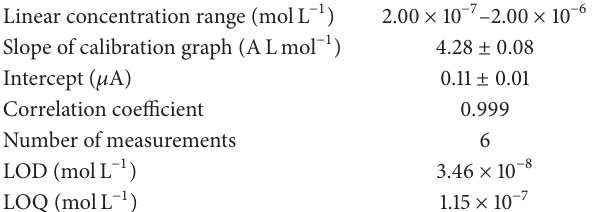
Table 1: Quantitative determination of nitrothal-isopropyl in BR buffer; pH = 2.5 with SWSV. Basic statistic data of the regression line.